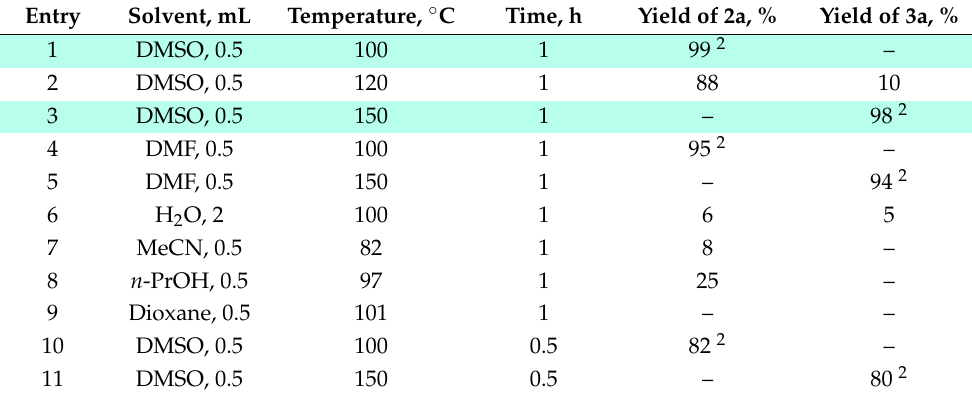
Table 1. Optimization of thermal rearrangement conditions 1